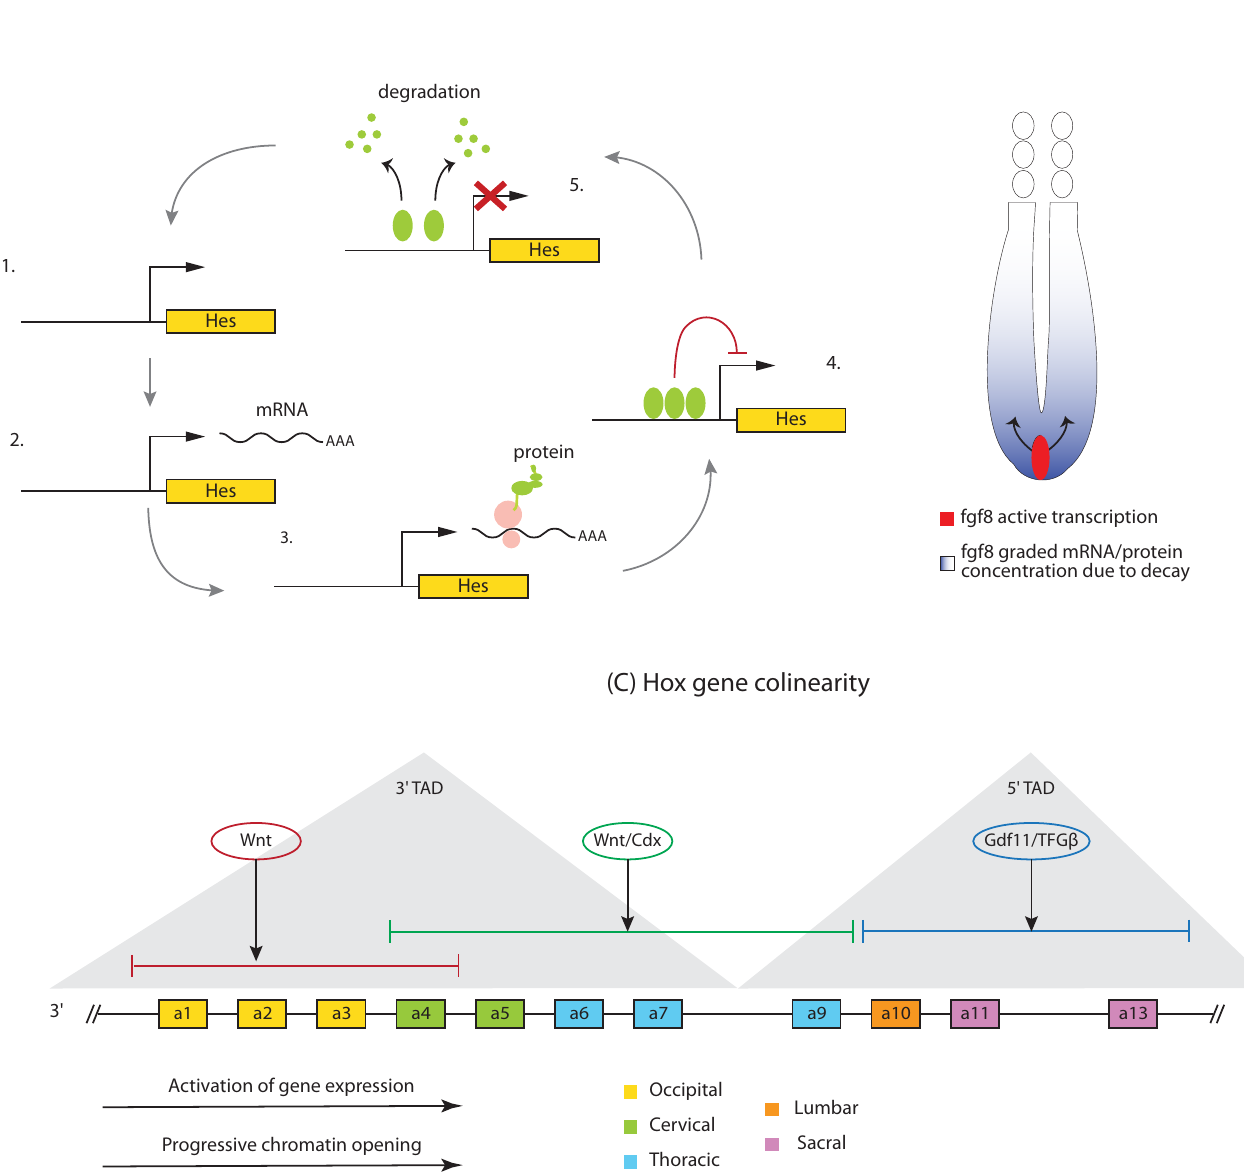
Fig 7. Mechanisms of segmentation and regionalization in vertebrates. (A) Delayed negative feedback loop giving rise to oscillations in Hes/Her expression. In the absence of transcriptional repression by autoinhibition (1), Hes/Her genes are activated and mRNA transcribed (2). This leads to HES/HER protein translation (3) and accumulation. After a time delay associated with gene expression steps, HES/HER proteins reach sufficient levels to bind the Hes/Her regulatory regions and inhibit transcription (4). Autoinhibition is relieved by HES/HER degradation (5) and the cycle begins again. (B) Mechanism of FGF gradient formation. Only progenitor cells (pink) actively express the fgf8 ligand. Once cells ingress into the PSM (purple), they cease to transcribe fgf8 . Progressive degradation of fgf8 mRNA and protein leads to gradient formation as cells acquire more anterior positions within the paraxial mesoderm. (C) Genomic organization of the HoxA cluster. HoxA1-13 genes are arranged colinearly within the cluster in the 3 0 to 5 0 orientation. Chromatin opening and gene expression start at the 3 0 end and proceed in the 3 0 to 5 0 direction. Genes are colored according to the vertebral identities they specify. The 2 TADs (3 0 and 5 0 ) are shown as gray triangles. Anterior Hox genes are activated by Wnt signaling (red), central Hox genes by Wnt/Cdx (green), and posterior Hox genes by Gdf11/ TGF β (blue). PSM, presomitic mesoderm; TAD, topologically associated